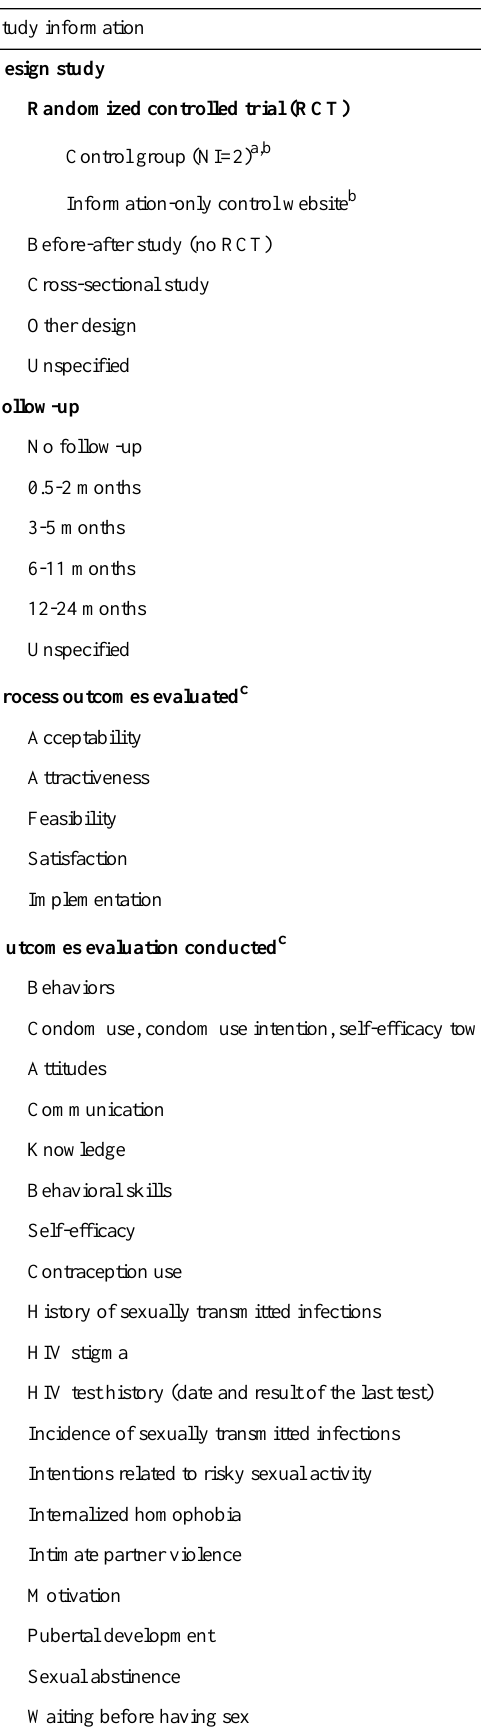
Table 4. Intervention design and evaluation methodology